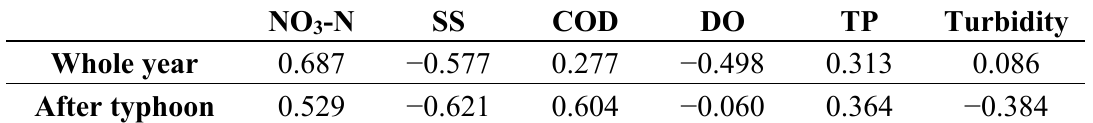
Table 2. Correlation coefficients of average NDVI and water quality in whole year and after typhoon.